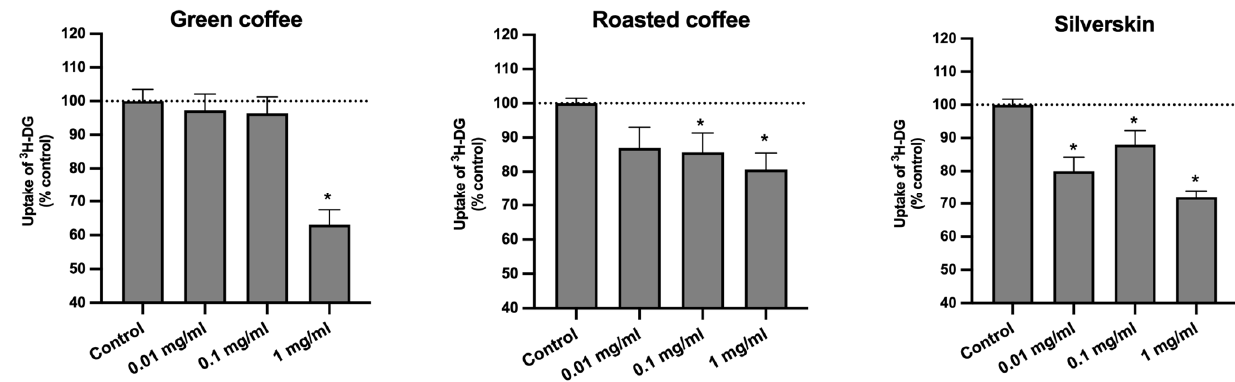
7 of 15 Figure 1. Effect of green coffee (GC), roasted coffee (RC), and coffee silverskin (S) extracts (1 mg/mL) on: ( A ) Caco-2 cell viability, determined by quantification of extracellular LDH activity), and ( B ) culture growth, determined with the SRB assay. Cells were cultured for 24 h in the presence of GC, RC, and S extracts ( n = 4–10) or the respective solvent (control; n = 8–10). The results are shown as arithmetic means ± SEM. *, significantly different from control ( p < 0.05; Student’s t -test).